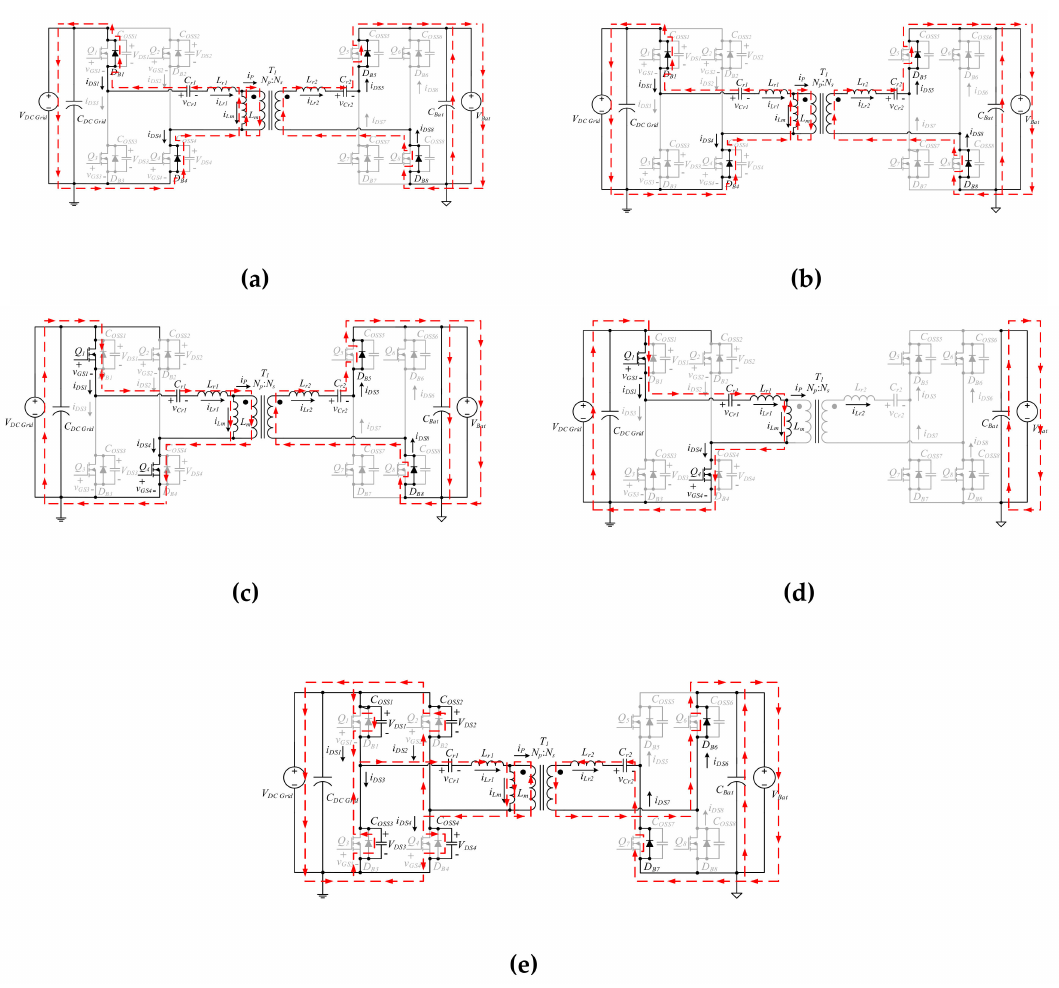
Figure 6. The conduction path of each stage in Region II: ( a ) Stage I conduction path; ( b ) Stage II conduction path; ( c ) Stage III conduction path; ( d ) Stage IV conduction path; ( e ) Stage V conduction